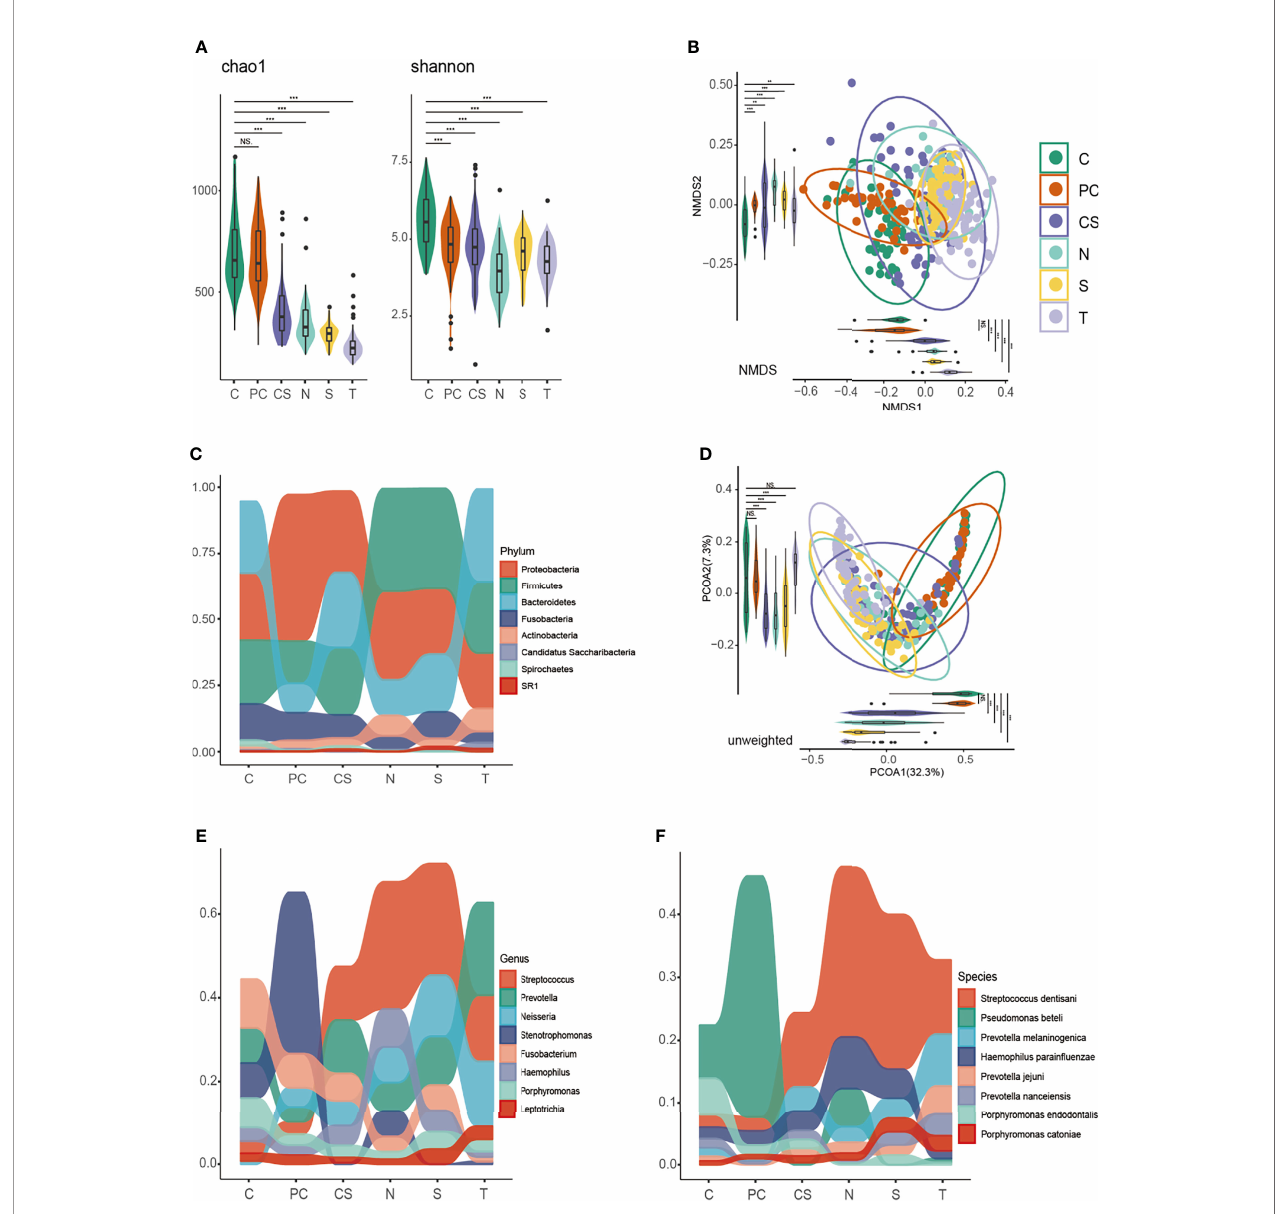
FIGURE 1 | Diversity analysis and taxonomy distribution of the oral microbiome among six niches. Bacterial richness, evenness and diversity were evaluated by (A) Chao 1 and Shannon index. Clusters formed by (B) non-metric multidimensional scaling (NMDS) and (D) principal coordinate analysis (PCoA) based on unweighted UniFrac. Differential taxonomy distribution at the (C) phylum, (E) genus and (F) species level. C, tumor tissue; PC, paracancerous tissue; CS, cancer surface; N, anatomically matched contralateral normal mucosa; S, saliva; T, tongue coat. ns, no signi fi cance; **P<0.005,